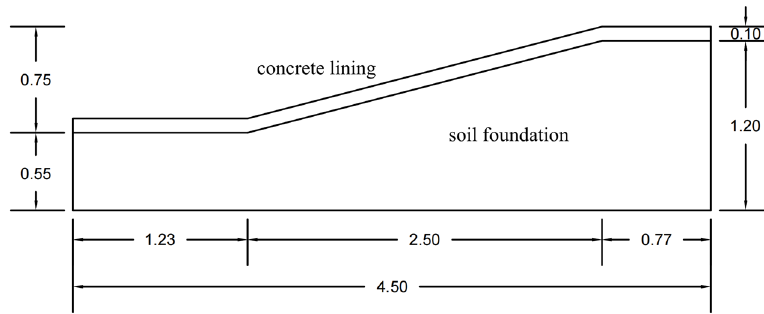
Figure 1. Geometry model of the canal (m).